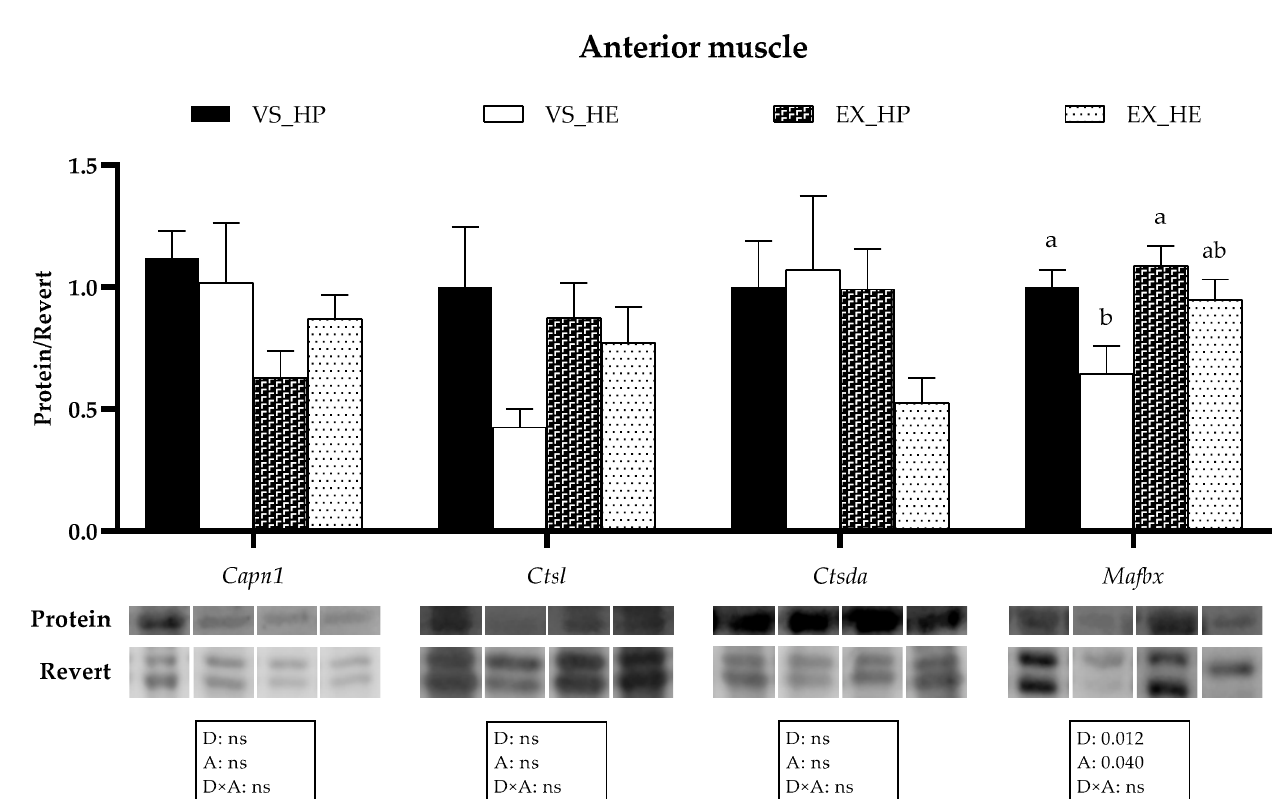
Figure 6. Representative western blot and densitometric analysis of proteolytic markers’ protein levels in anterior muscle of fish under voluntary swimming (VS) or sustained exercise (EX) and fed with high-protein diet (HP) or high-energy diet (HE). Bands were normalized to their Revert TM total protein staining (corresponding well is shown). To eliminate intermembrane variability, relative intensity of each specific band was normalized by geometric mean of intensity of that of VS_HP diet group of corresponding membrane. Data are shown as means + SEM. VS and EX, n = 6. Factorial statistical analysis was assessed by two-way ANOVA, and p -values of the factors diet (D), physical activity (A), and the interaction (D × A) are displayed under graph. Different letters indicate significant differences (Tukey’s post-hoc test, p < 0.05). (The raw images captured for the Western Blot analysis are compiled in the supplementary Figure S1).